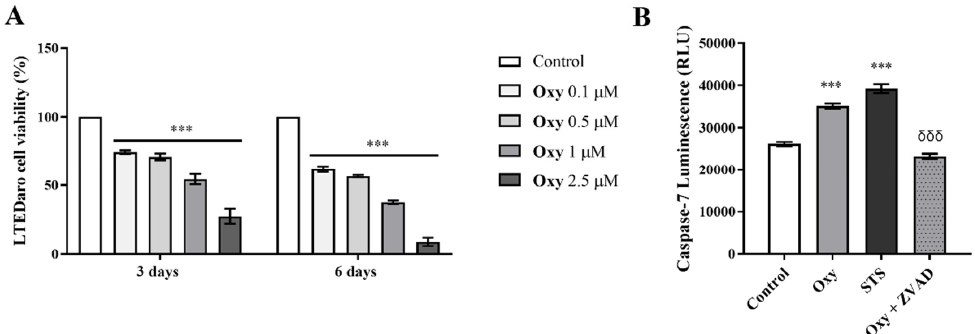
Figure 9. Effects of Oxy on viability and cell death of apoptosis of resistant breast cancer cells. ( A )